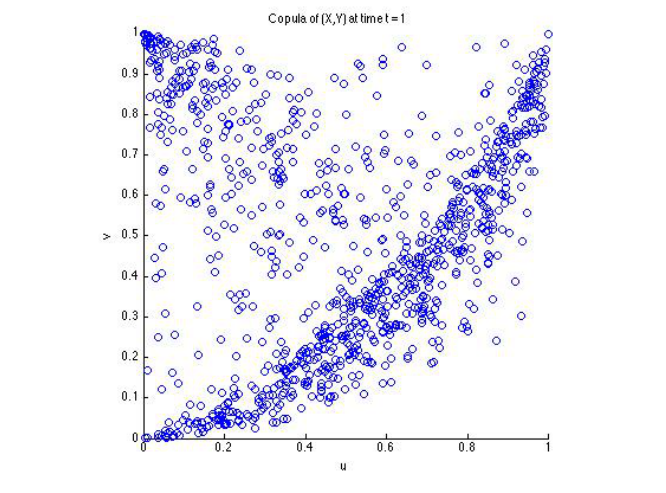
Figure 7: Empirical copula of ( X t , Y t ) in the local correlation model at time t = 1 with parameters ν = 0, η = 0.5 , ρ 1 = −0.9 and ρ 2 = 0.9 and a time step of 0.001 with 1000 simulations